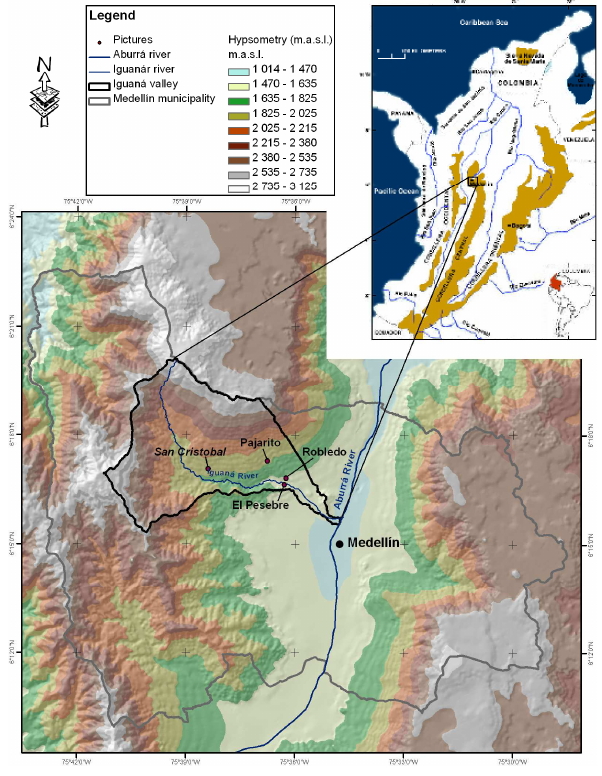
Fig. 1. Location of the Iguan´a River Basin, Colombia.